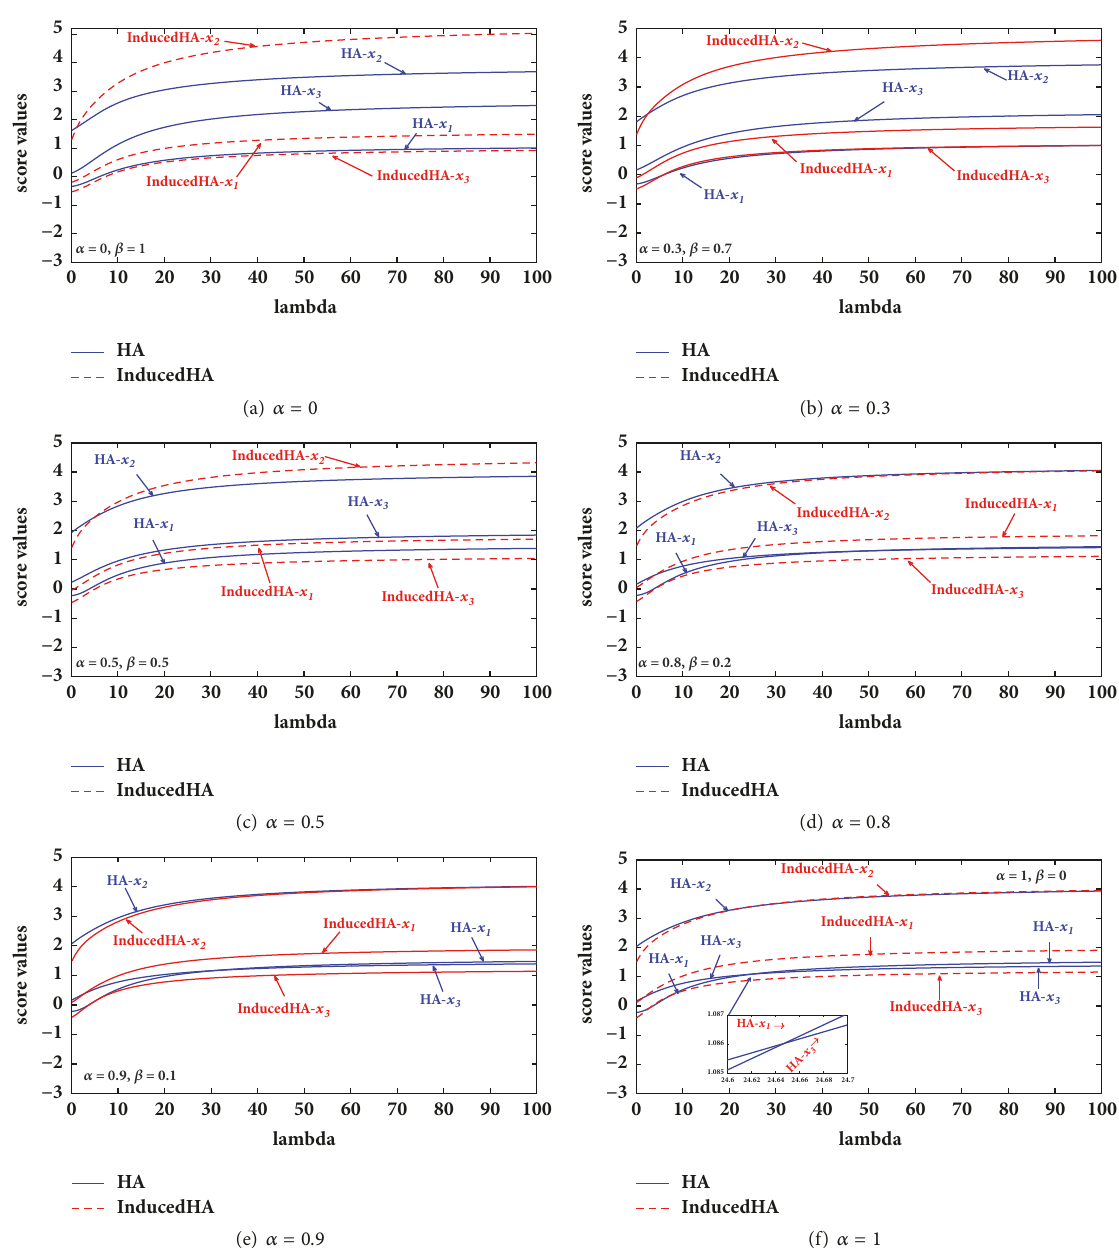
Figure 5: Score trajectories obtained by aggregation operators HA and InducedHA with different configuration of 𝛼 : (a) 𝛼 = 0, (b) 𝛼 = 0.3, (c) 𝛼 = 0.5, (d) 𝛼 = 0.7, (e) 𝛼 = 0.9, and (f) 𝛼 =